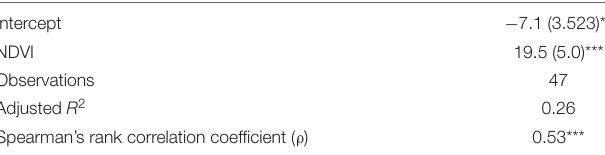
TABLE 3 | Ordinary least squares (OLS) regression results. The dependent variable is the total biomass expressed in tonnes for each 0.1 ha plots regressed on average NDVI for the same plot area.